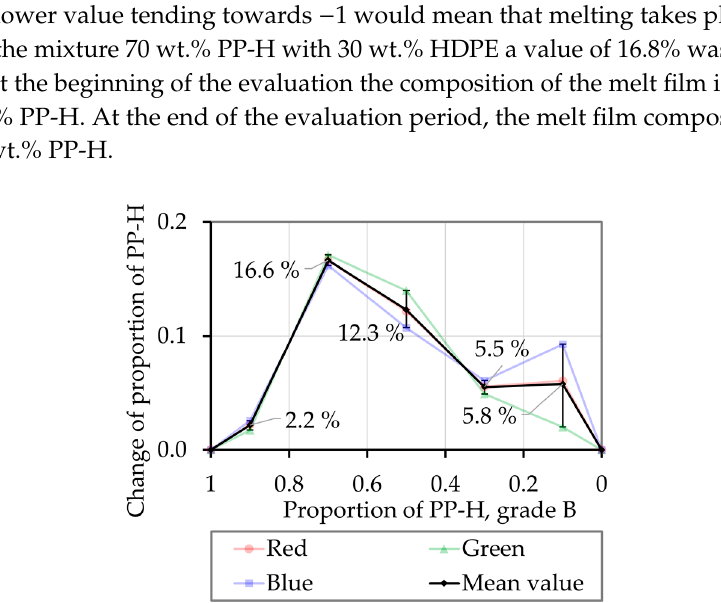
( b ) Figure 18 . Composition of the light in the melt film for the mixture PP-H/HDPE as a function of the proportion of PP-H, grade B: ( a ) Mean values, the dashed line shows the linearized functions; ( b ) the change of the composition of the light Δ𝜉̅ (cid:3019)(cid:3008)(cid:3003),(cid:3020)(cid:2871) ; The relation of the change of the proportion of light during the third section Δ𝜉 (cid:3019)(cid:3008)(cid:3003),(cid:3020)(cid:2871) and the change of the proportion of light caused by the material Δ𝜉 (cid:3019)(cid:3008)(cid:3003),(cid:3014)(cid:3028)(cid:3047) defines the change of the melted